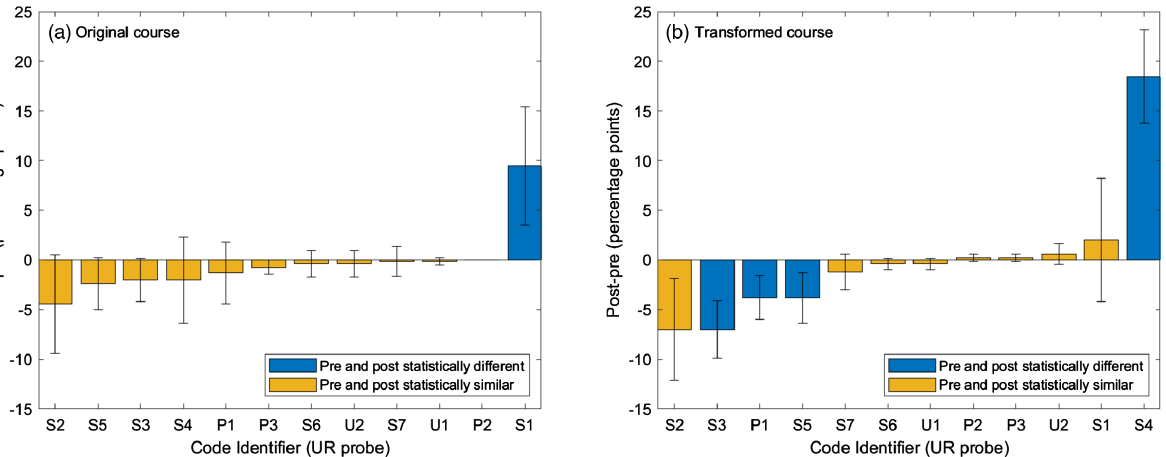
FIG. 5. Pre-post differences in code counts for the UR probe, for the original course (a) and the transformed course (b). (b) Reproduced from Ref. [10]. Blue bars are statistically significant differences using Fisher ’ s exact test at the 95% confidence interval, adjusted using the Holm-Bonferroni method. Orange bars are not significant by that same test. Error bars are the binomial proportion confidence interval at the 95% confidence